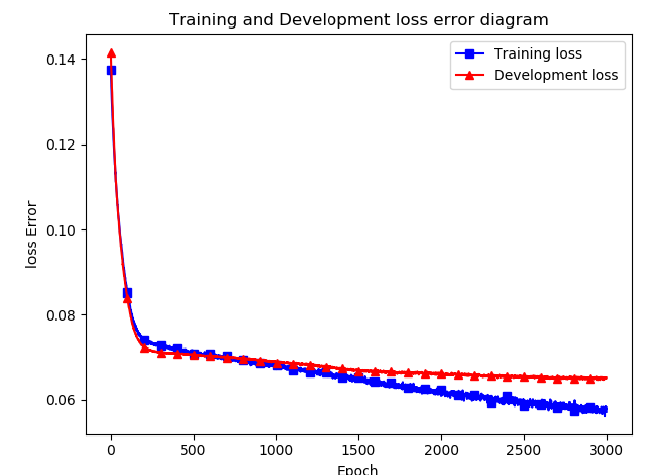
Fig. 7. Training and development loss error diagrams for conscientiousness trait classification in the SPC dataset was evaluated using the conventional 10-Fold CV